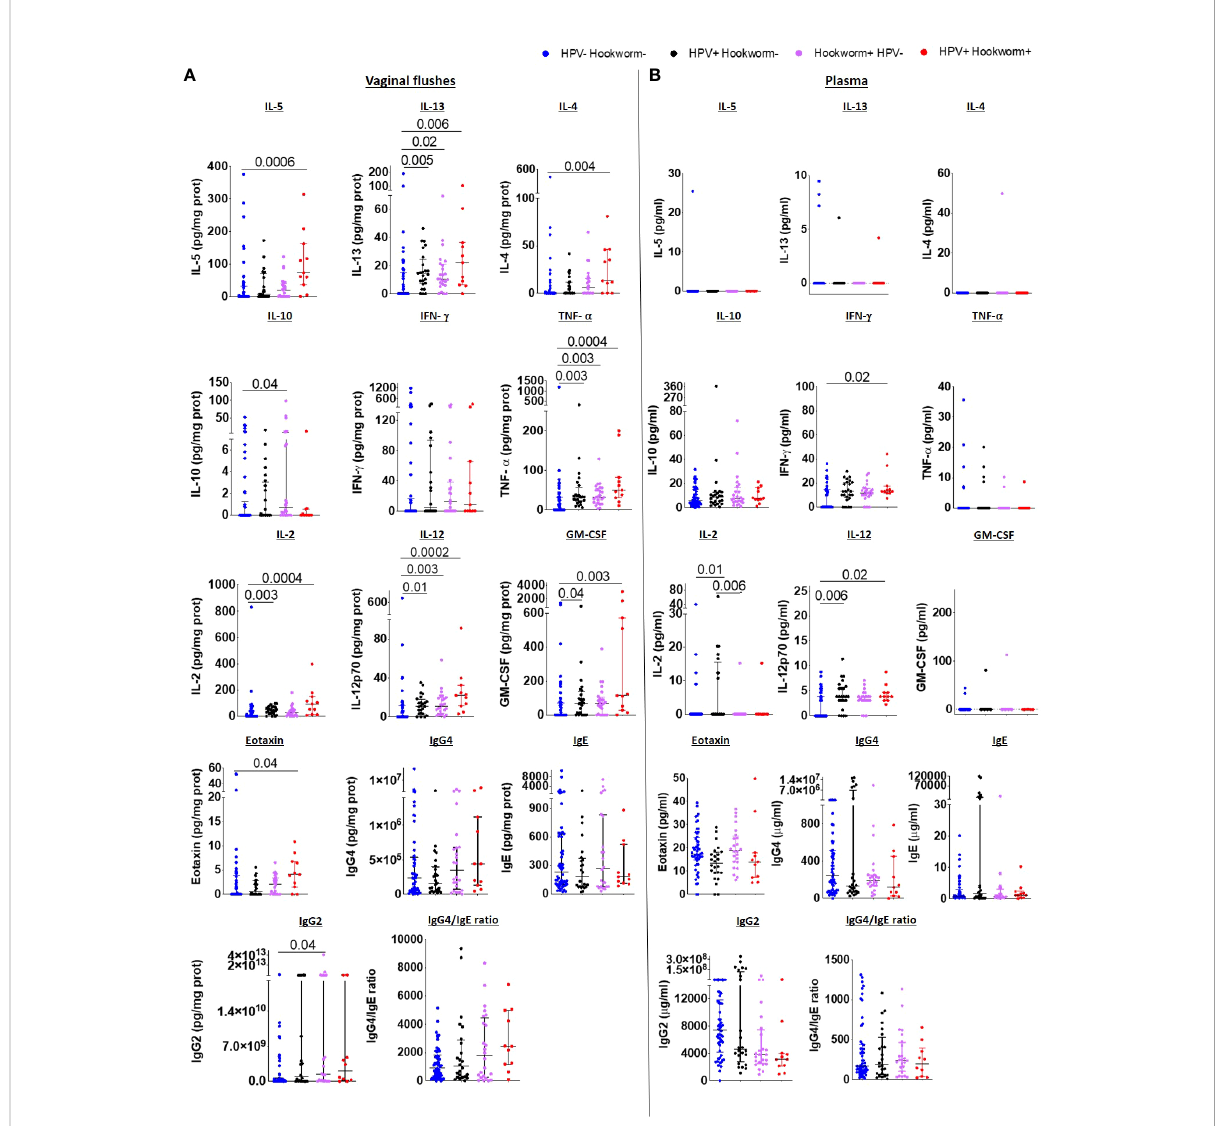
FIGURE 5 Type 2 immune responses are elevated in the FRT of HPV and hookworm co-infected women IL-5, IL-13, IL-4, IL-10, IFN- g , TNF- a , IL-2, IL-12, GM-CSF, eotaxin, IgG4, IgE, IgG2 levels, and IgG4/IgE ratio in the vaginal fl ushes (A) and plasma (B) of HPV and hookworm negative, single- infected and co-infected women. Each dot represents a single individual, horizontal bars indicate the median and IQR. To normalize VF data, individual analyte concentrations were expressed as ratio of the measured parameter and the total protein concentration of the sample. Hookworm- HPV- (n=54), hookworm- HPV+ (n=24), hookworm+ HPV- (n=24), hookworm+ HPV+ (n=11). Kruskal Wallis with Dunn ’ s multiple comparisons test were used to compare HPV and hookworm negative, single-infected and co-infected